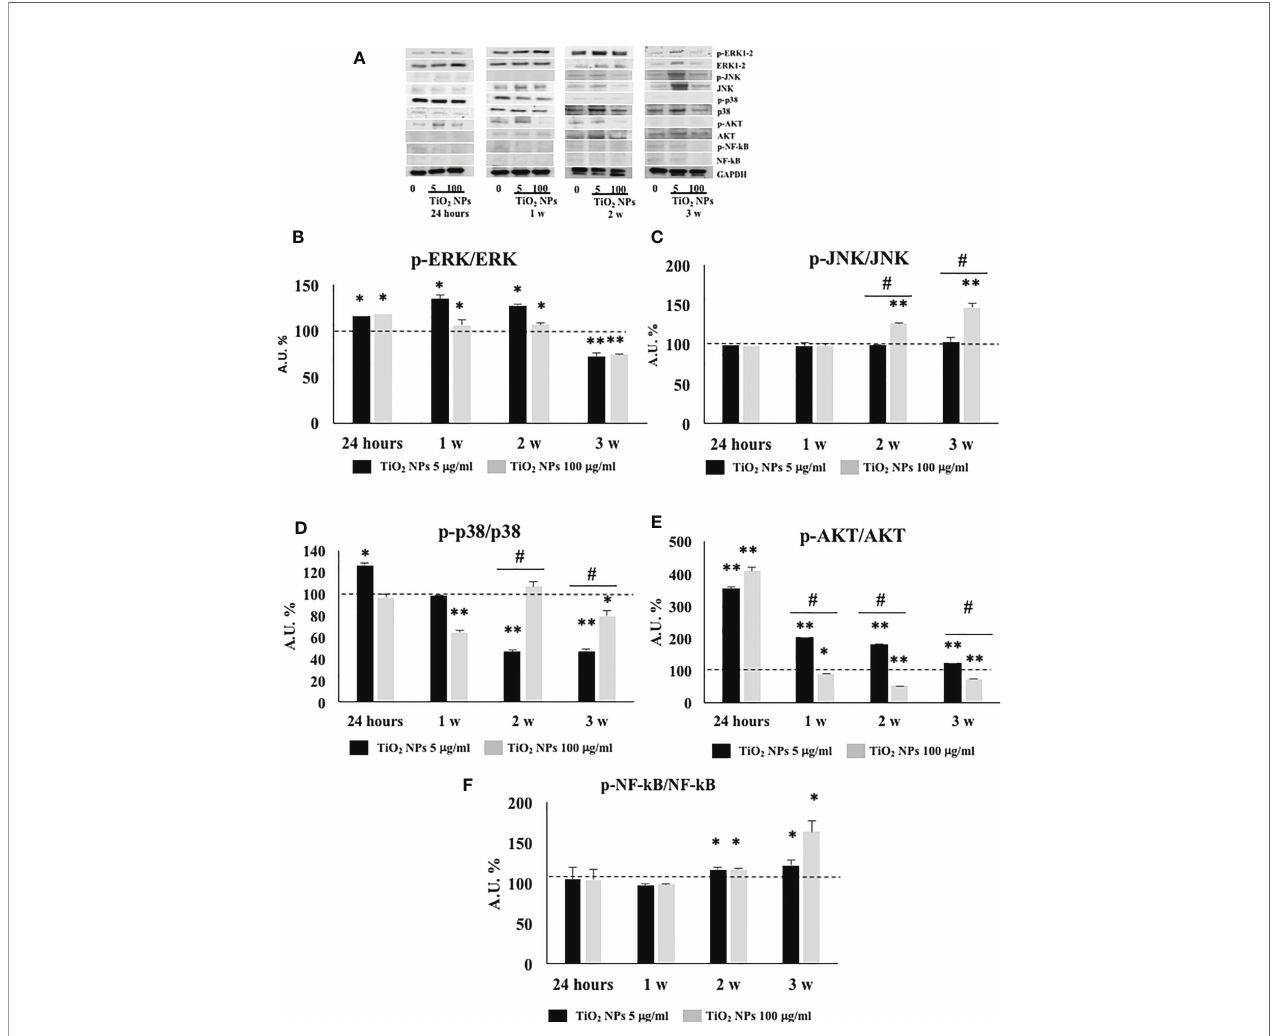
FIGURE 10 | WB analysis. (A) Immunoblots of phosphoERK1-2/ERK1-2, phosphoJNK/JNK, phosphop38/p38, phosphoAKT/AKT, posphoNF-kB p65/NF-kB, and GAPDH in SCs 24 h and 1, 2, and 3 weeks of incubation with TiO 2 NPs 5 and 100 µg/ml. Densitometric analysis of the protein bands of phosphoERK1-2/ERK1-2 (B) , phosphoJNK/JNK (C) , phosphop38/p38 (D) , phosphoAKT/AKT (E) , and phosphoNF-kB p65/NF-kB (F) in SCs 24 h and 1, 2, and 3 weeks of incubation with TiO 2 NPs 5 (black bar) and 100 µg/ml (grey bar). Data represent the mean ± SEM (* p < 0.05, ** p < 0.001 vs. unexposed SCs (black dotted line) and # p < 0.05 vs. 5 µg/ml of